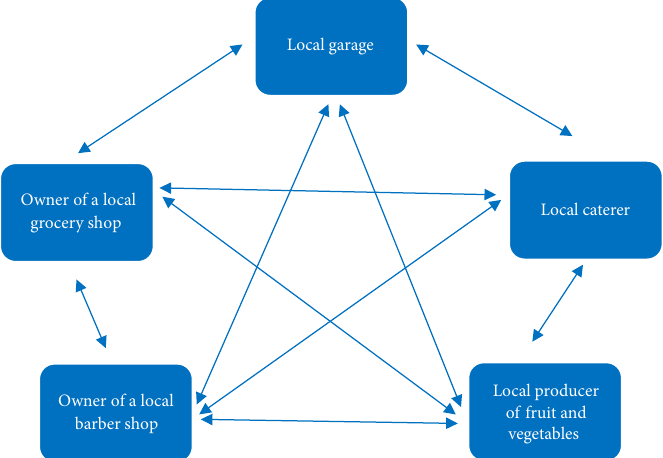
Figure 9. Simplified example of the circulation of the complementary currency Zielony in the local economy (own elaboration)